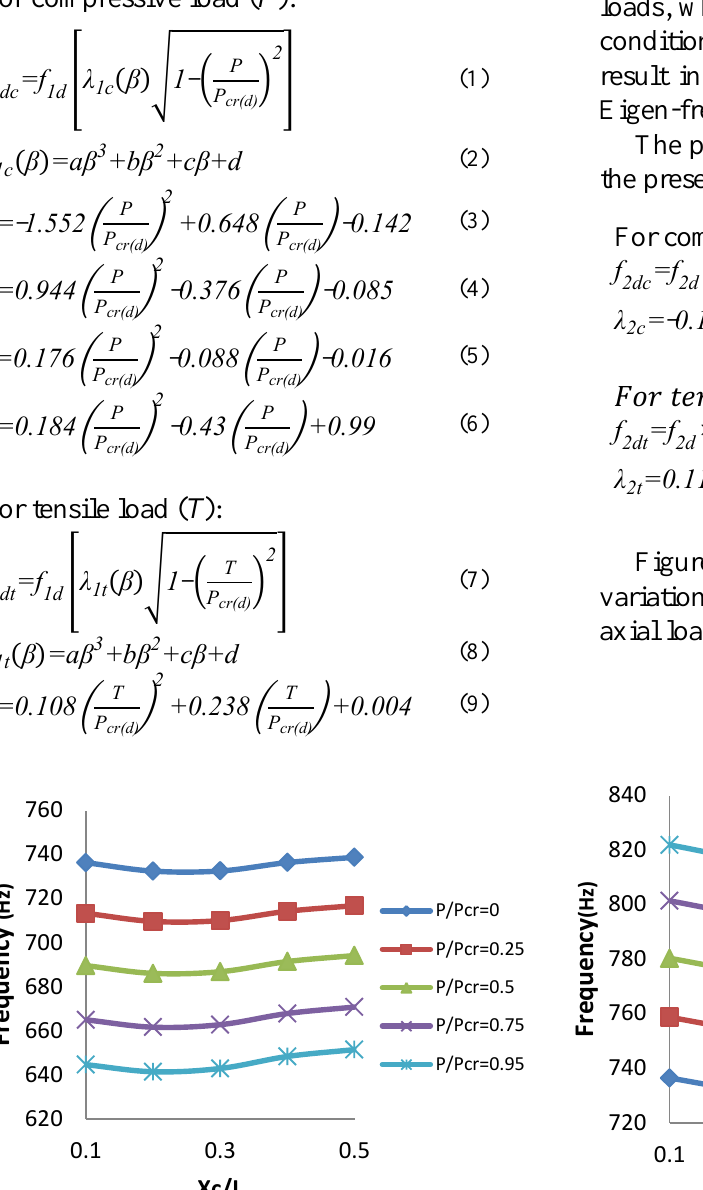
Fig. 4. Second frequency of cracked beam, subject to compressive loads